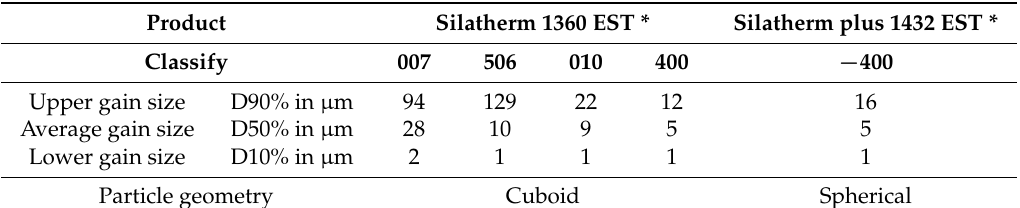
Table 2. Particle size distribution of fillers (information from